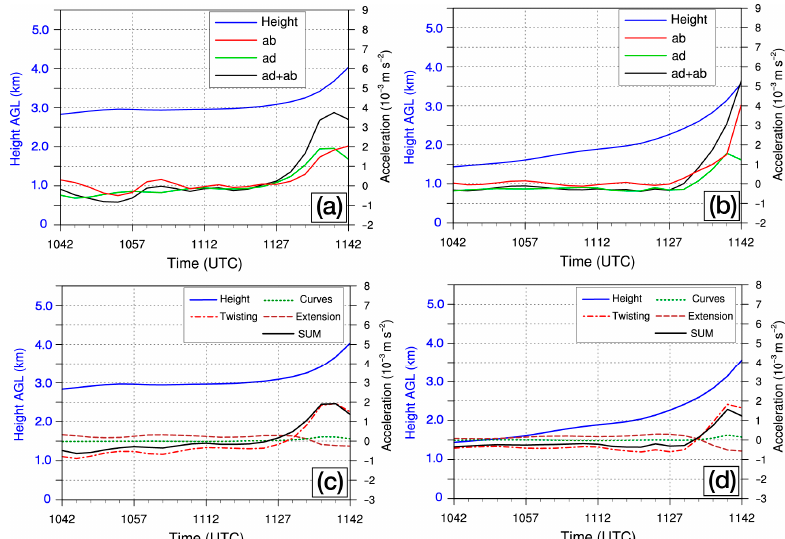
Figure 13. ( a ) Averaged height and vertical momentum components induced by buoyancy ( a d ), dynamical force ( a d ) and sum of them ( a b + a d ) along the air parcels from southwest within the C2. ( b ) is the same as (a) but for the air parcels from south within the C2. ( c ) Averaged height and three components (curves, twisting and extension) of the dynamic acceleration ( a d ) and sum of them (SUM) along the air parcels from southwest within the C2. ( d ) is the same as ( c ) but for the air parcels from south within the C2.